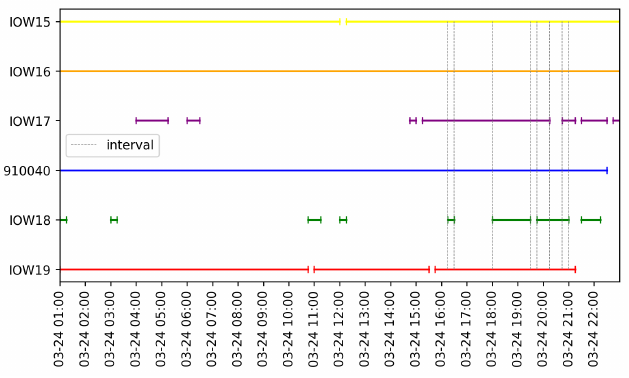
Figure 26. CPs result for Query 7 using local thresholds and ec =